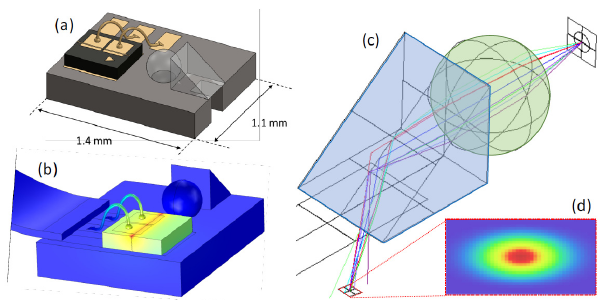
Figure 9. Tyndall micro-optical bench (MOB); ( a ) Schematic of the MOB showing the laser-chip, ball lens, and micro-prism; ( b ) COMSOL -software thermal model of the MOB showing the elevated temperature of the laser-chip during CW operation; ( c , d ) Zemax ray-tracing applied to the MOB shows